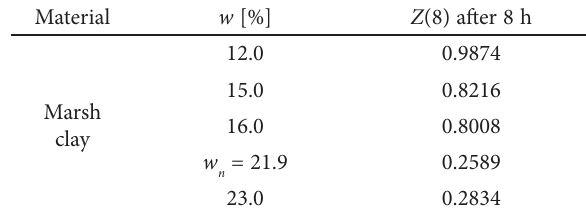
Table 8. Disintegration number Z (8) of marsh clay Material